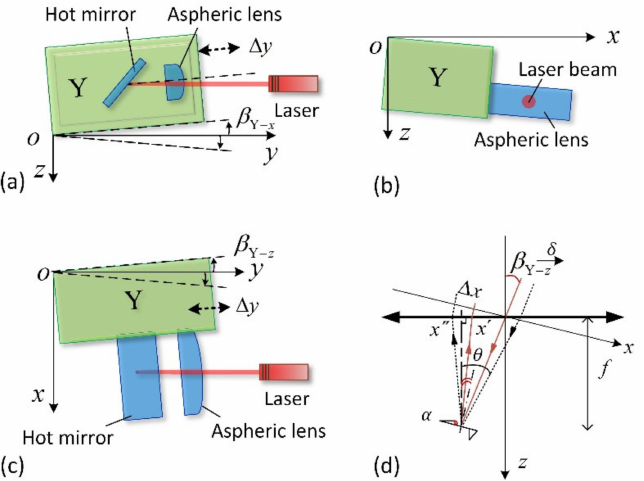
Figure 3. Typical schematic diagram of an obliquely installed Y-scanner. Installation diagrams of the Y-scanner installed obliquely around the x -axis ( a ), around the y -axis ( b ). Installation diagrams ( c ) and the simplified optical path ( d ) of the Y-scanner installed obliquely around the z